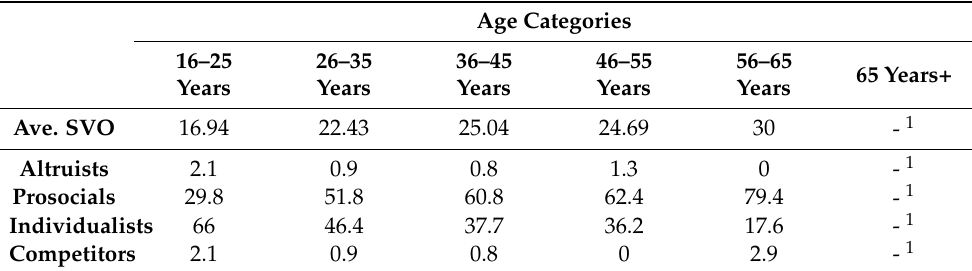
Table A2. Average Social Value Orientation (SVO) and percentage of altruists, prosoicals, individu- alists, and competitors for differing age groups in Japan calculated from data reported in [14] with respondents between the age of 19 and 59.